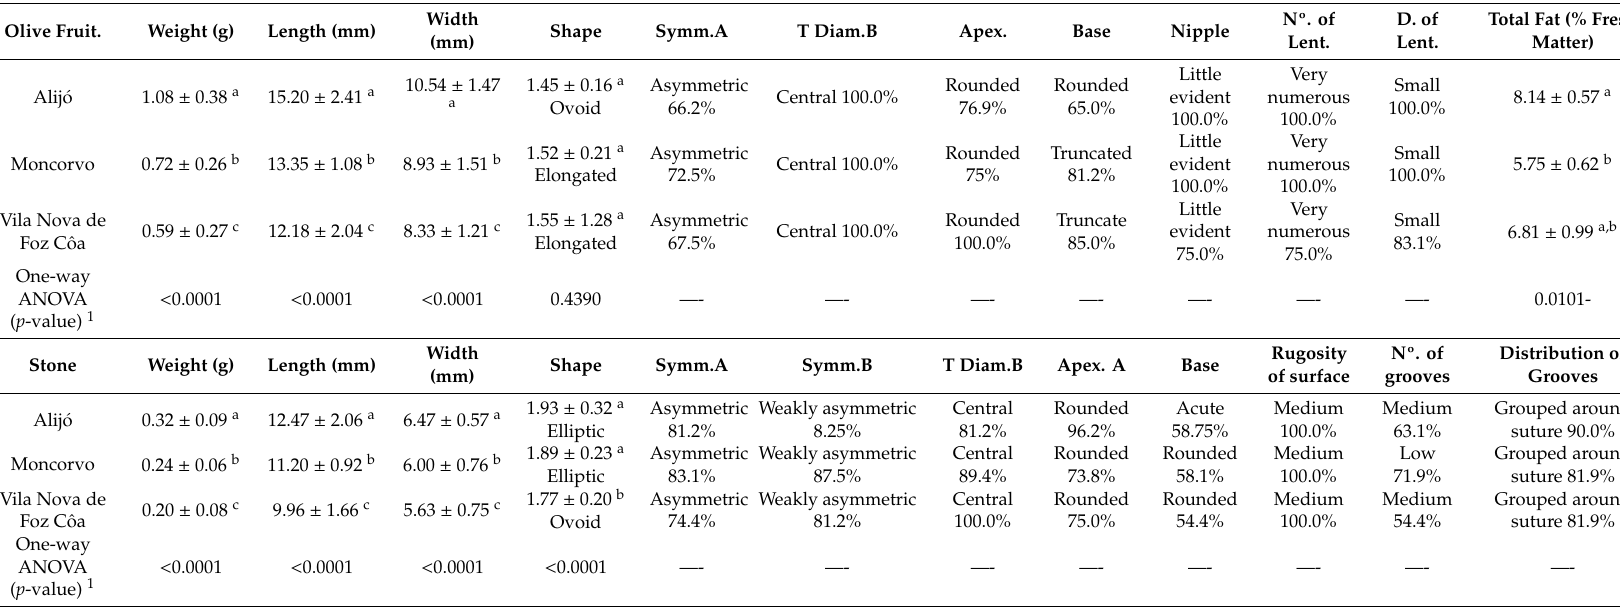
Table 1. Biometric and morphological characteristics of fruit and endocarp (mean ± standard deviation), in percentage (%) of occurrence, of oleaster fruits obtained. Olive